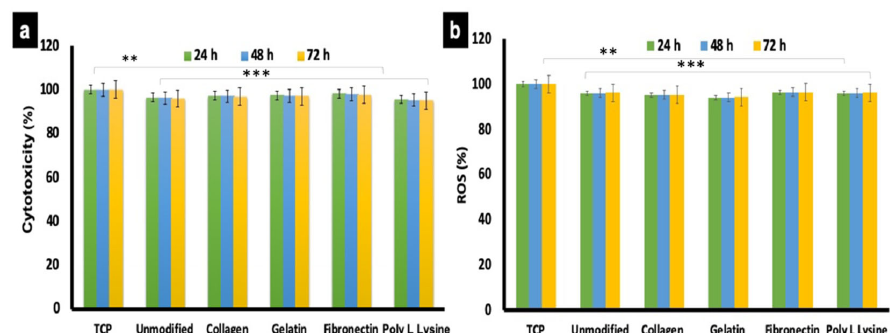
Figure 9. Cytotocompatibility and reactive oxygen species (ROS) generation analysis of AHCF cultured on unmodified and protein functionalized PLLA scaffolds. ( a ) No significant toxicity